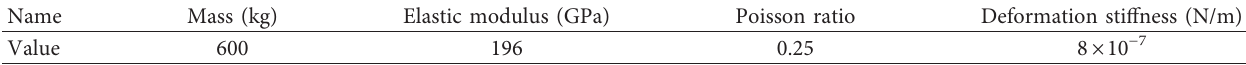
Table 7: Parameters of the casing.